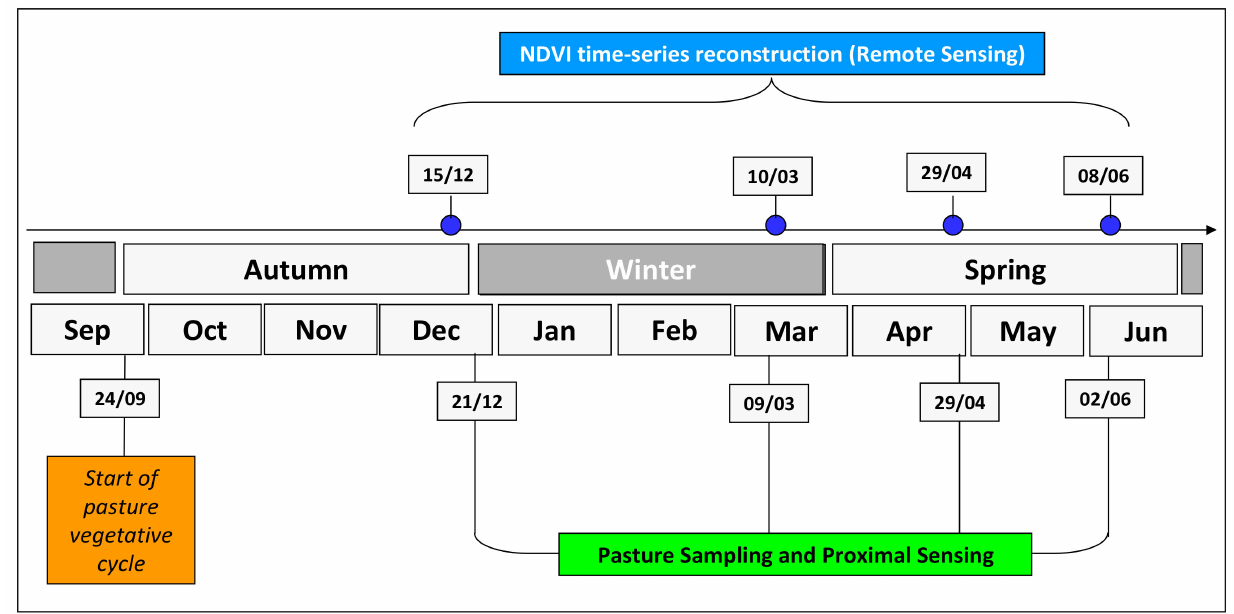
Figure 3. Monthly rainfall and monthly mean temperature between July 2015 and June 2022.